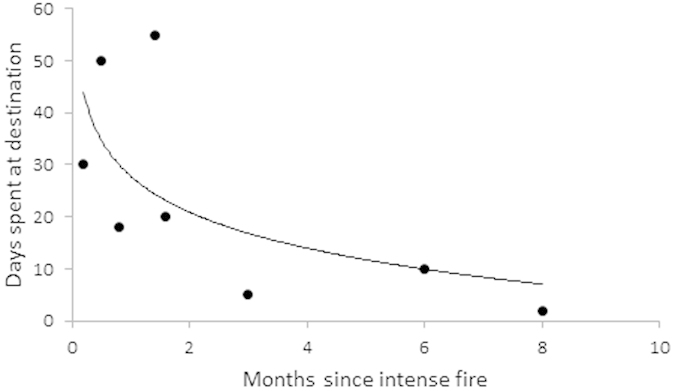
For cats expeditions to an intense fire scar, the duration of their visit in days is compared against the months since an intense fire at the destination.Graph was generated in Microsoft Excel 14.0.6112 (https://products.office.com/en-au/excel).